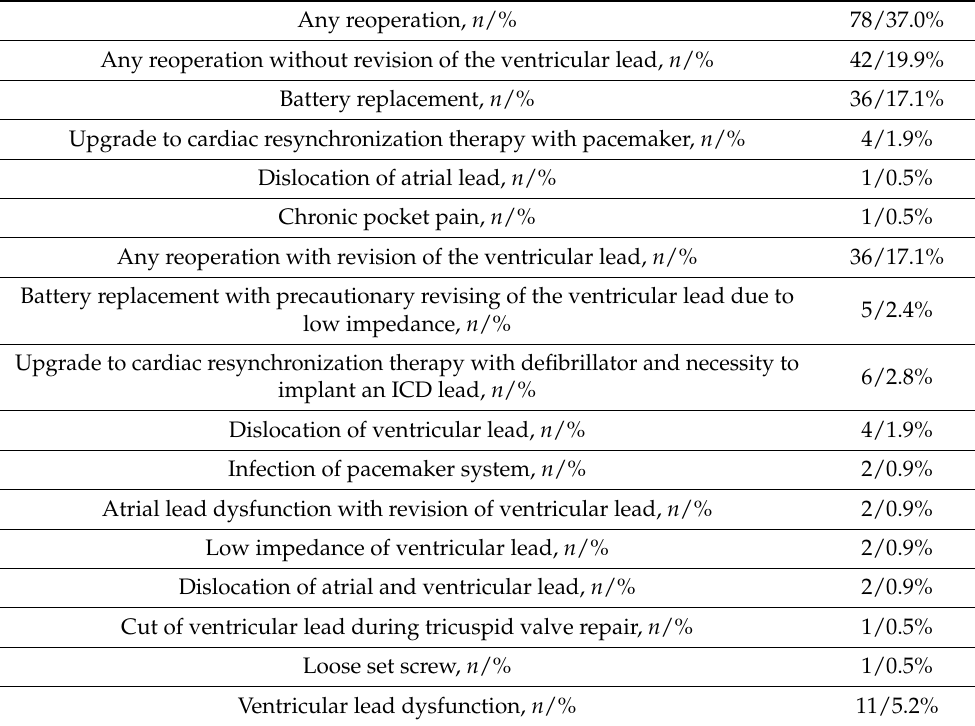
Table 3. All reoperations during long-term follow-up.